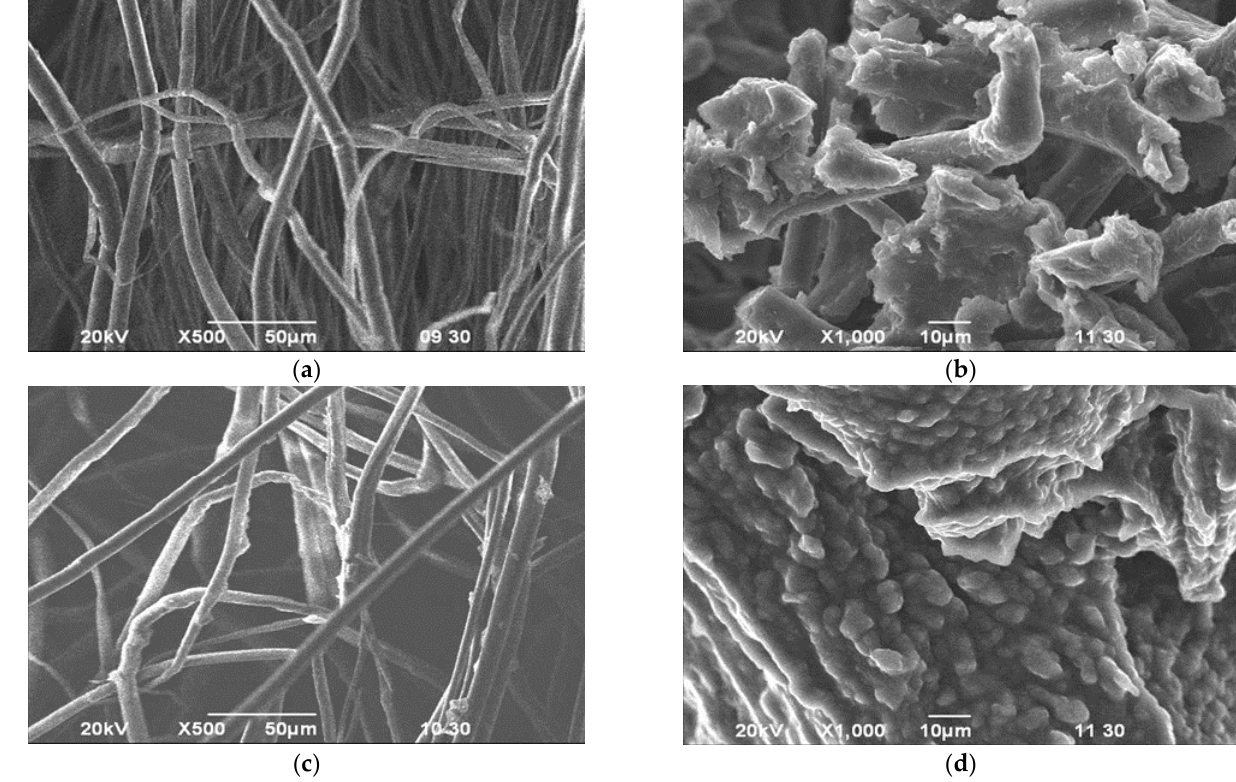
Figure 5. Non-grafted ( a , b ) and grafted ( c , d ) α -cellulose and MCC, respectively.